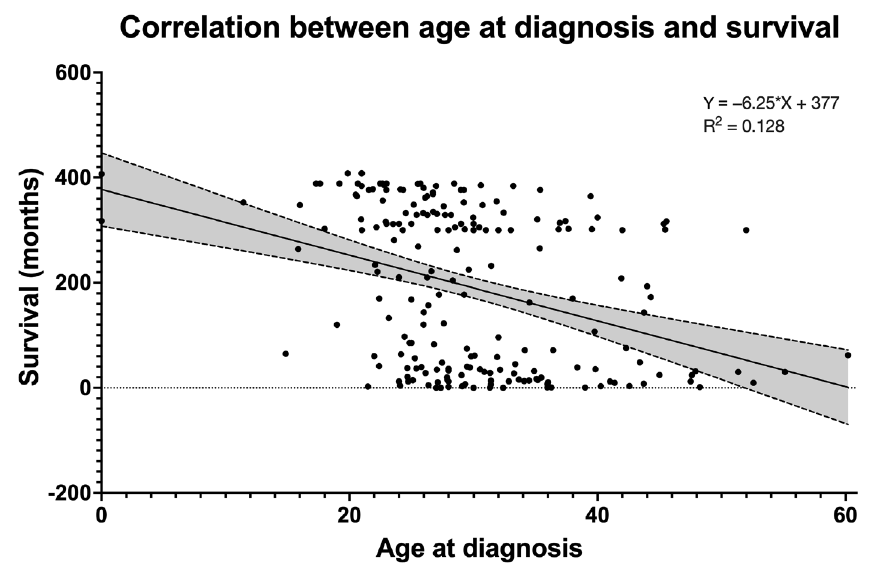
Figure 7. Age at diagnosis influences time of survival. This figure shows that a linear correlation might exist between age at diagnosis and time of survival, although this correlation is weak (R squared 0.128).